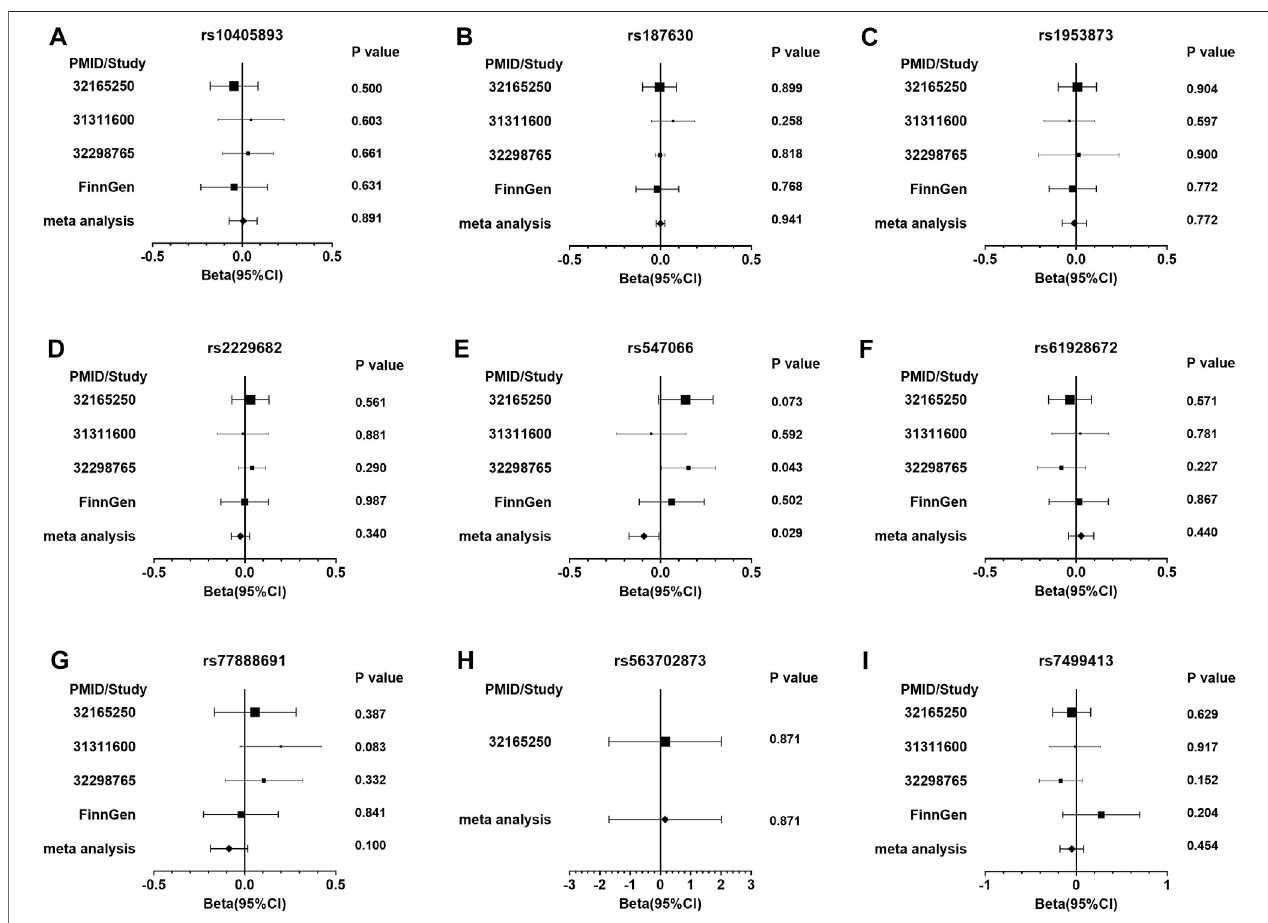
FIGURE 2 | The forest plots of the meta-analysis of NAFLD in glycogen SNPs associated with PDFF. Figure (A) presents rs10405893; (B) rs187630; (C) rs1953873; (D) rs2229682; (E) rs547066; (F) rs61928672; (G) rs77888691; (H) rs563702873; and (I) rs7499413.